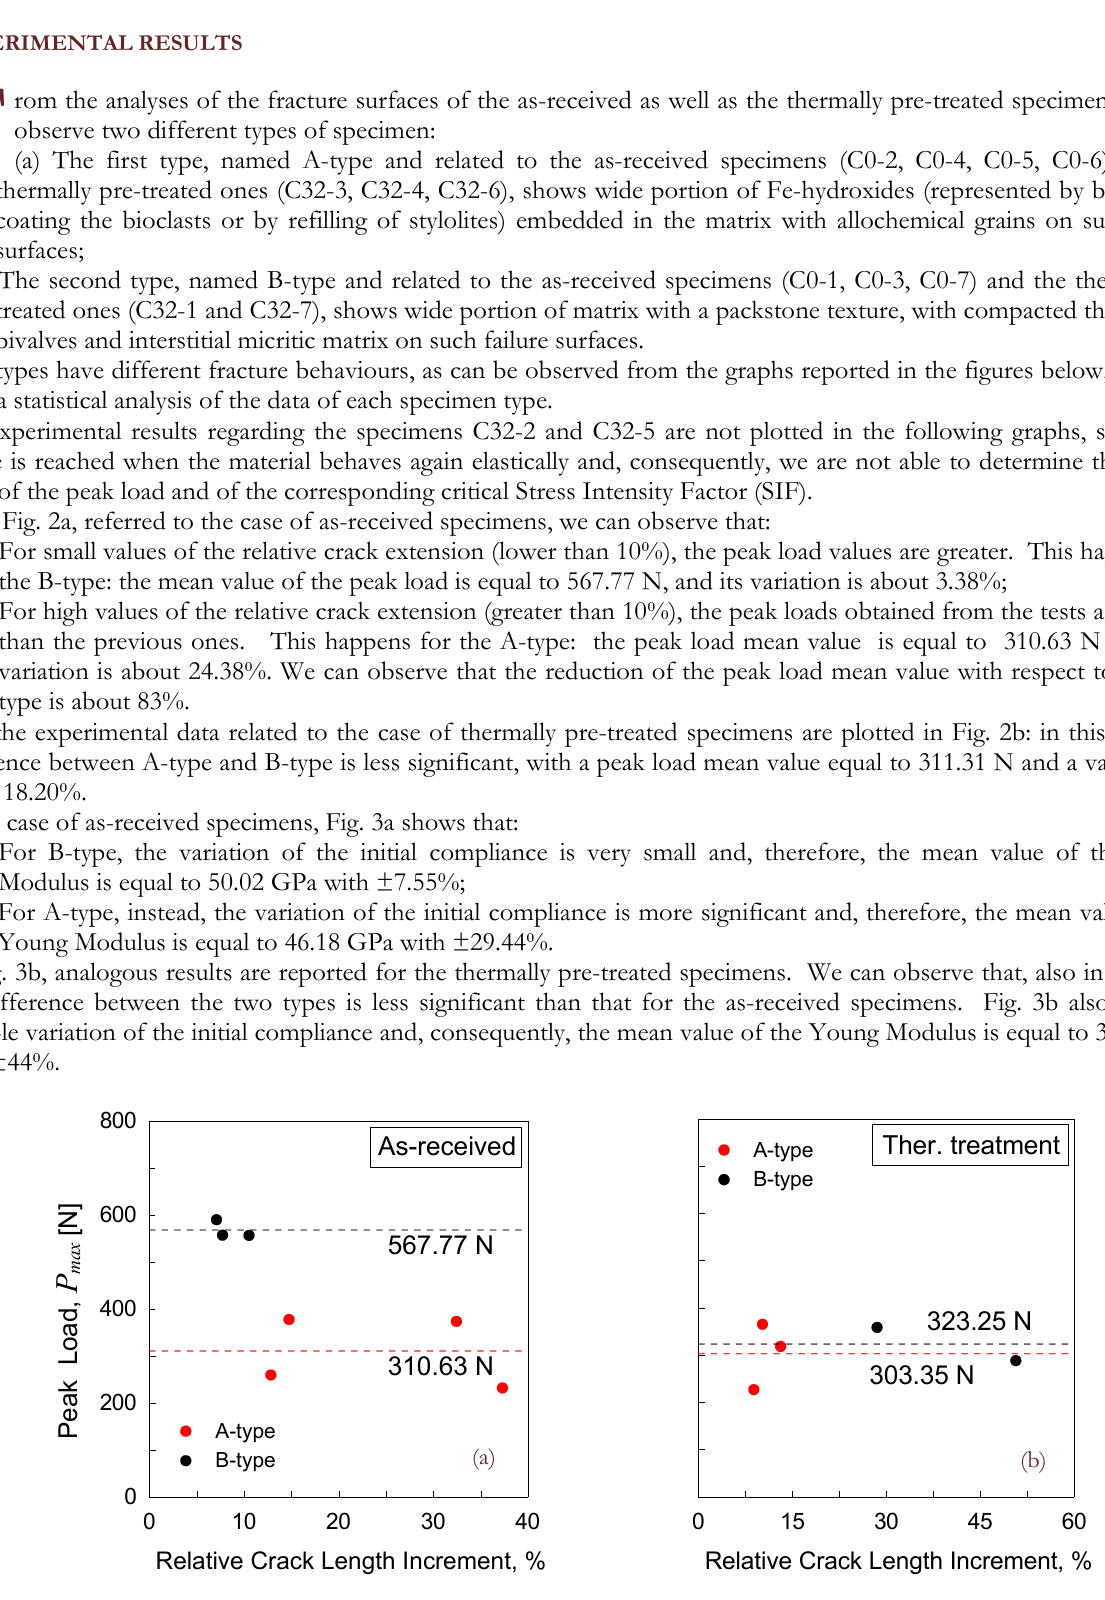
Figure 2: Peak load against relative crack length increment for: (a) the as-received and (b) the thermal pre-treated